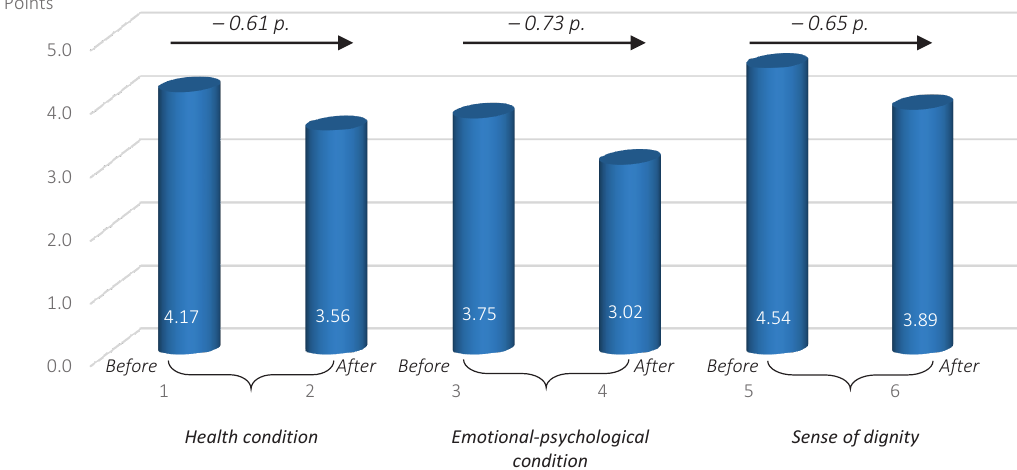
Figure 5. Differentiation of the impact of forced migration on the human capacity of IDPs